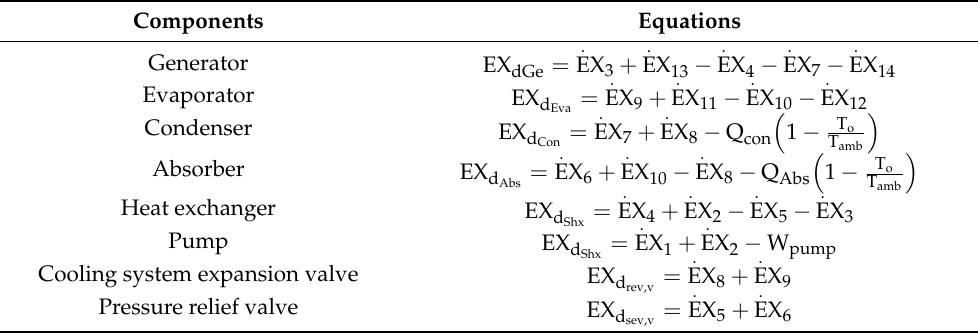
Table 1. Exergy balance equations for the absorption cooling cycle components.